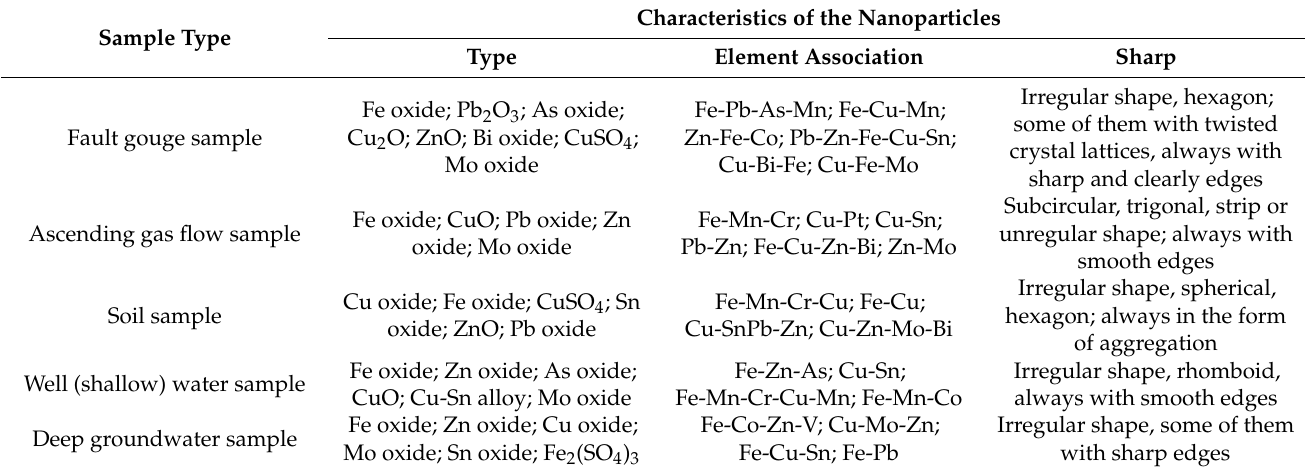
Table 5. Summary of the nanoparticles characteristics in the different sample